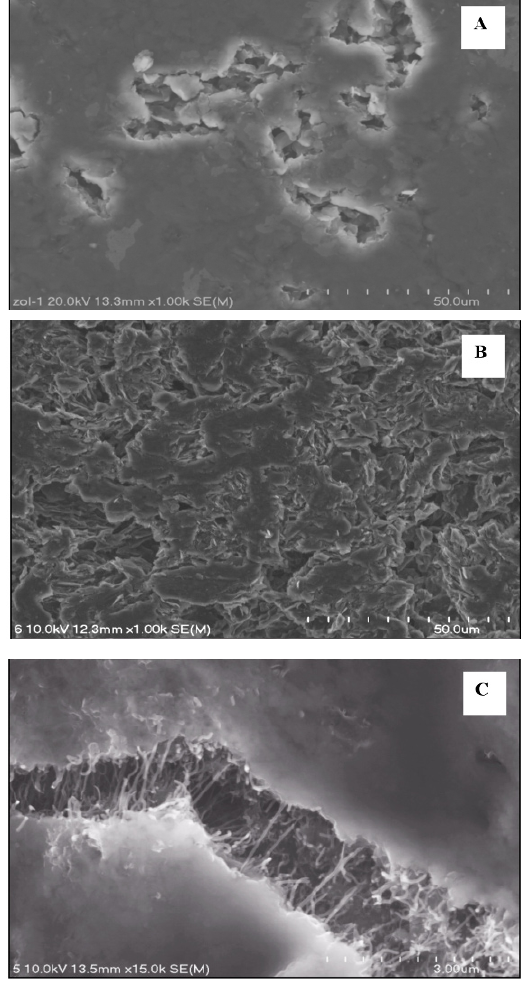
Figure 2. SEM images of pure TiO Nafion (B,C) nanocomposite (optimal composition) on the surface of graphite